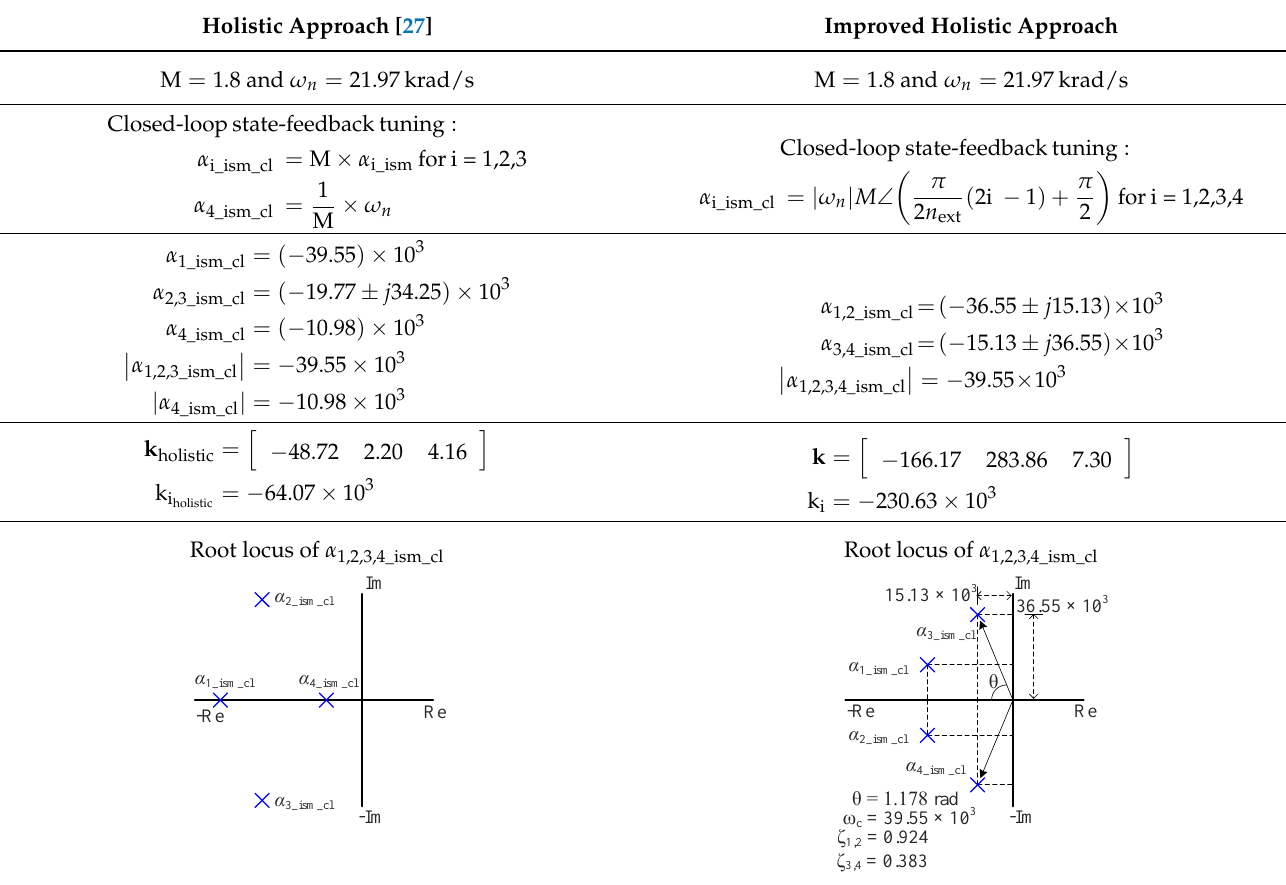
Table 4. Analytical comparison between improved holistic control and holistic control approaches. Holistic Approach [27] Improved Holistic Approach M = 1.8 and ω n = 21.97 krad/s M = 1.8 and ω n = 21.97